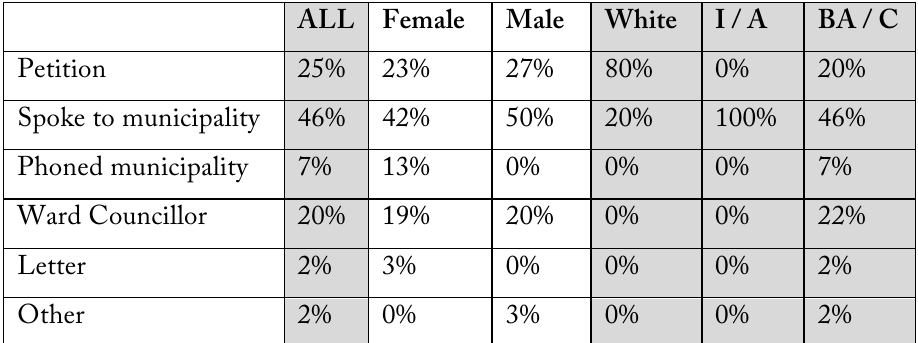
Table 5: Methods of complaint to municipality